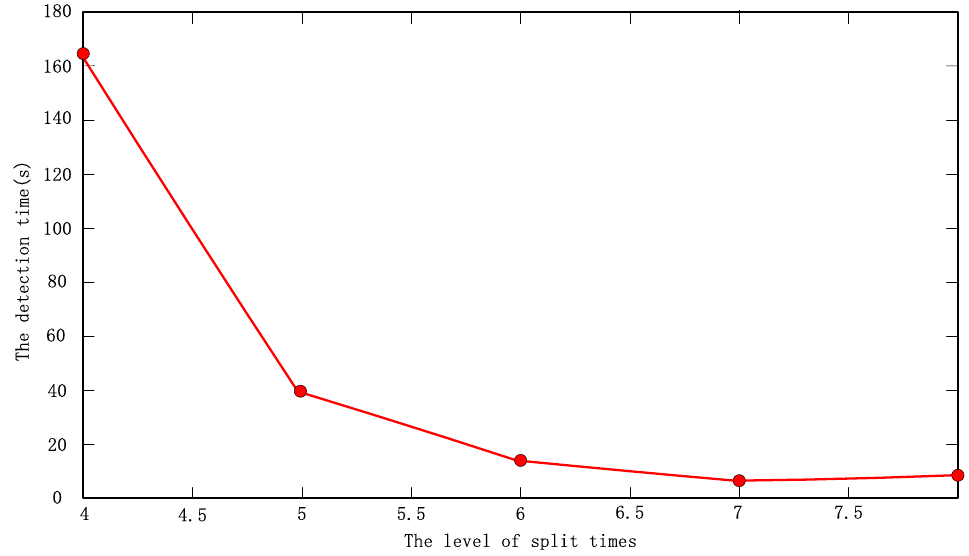
Table 1. Detection efficiency.